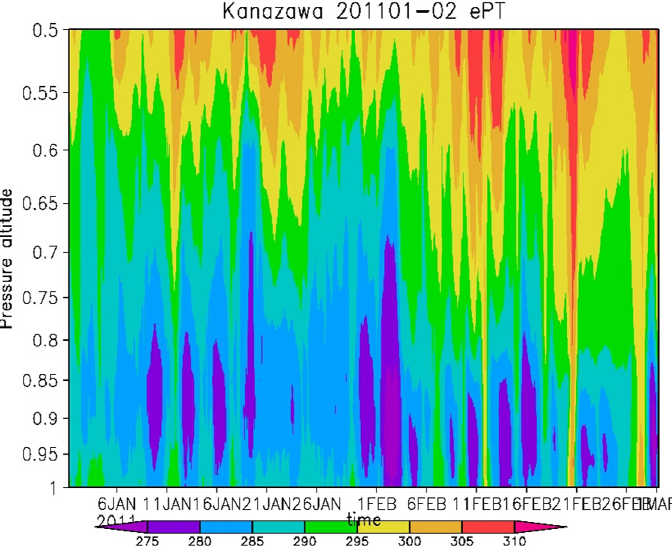
Figure 7. Vertical variations in ePT over Kanazawa from 1 January to 30 June 2011. Unit is K. The horizontal distribution of ePT at 850 hPa, the geopotential height anomaly at 850 hPa, and the p-PAH concentration in the Northeast Asia from 31 January to 5 February 2011 are shown in Figure 8. As already described, ePT is a conservation indicator of air mass three-dimensional transport. The geopotential height anomaly means deviation of air mass geopotential height at constant atmospheric pressure against the average values during the target period. The region with negative geopotential height anomaly occurs with lower geopotential heights. This implies that the air mass temperature over this region is lower than those average values. The variation of ePT as well as geopotential height anomaly are closely connected with the distribution or concentrations of atmospheric pollutants such as PAH.